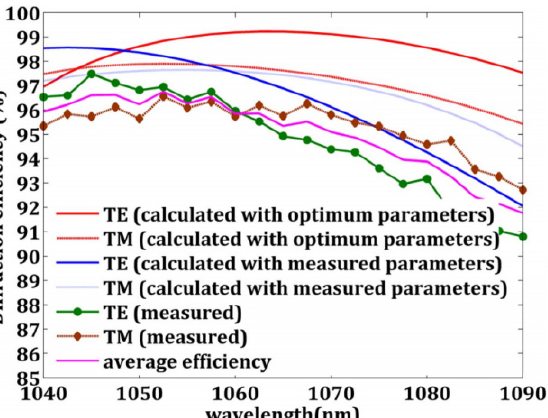
Figure 20. Relationship between the diffraction efficiency and wavelength of the theoretical calcula- tion and the actual measurement.